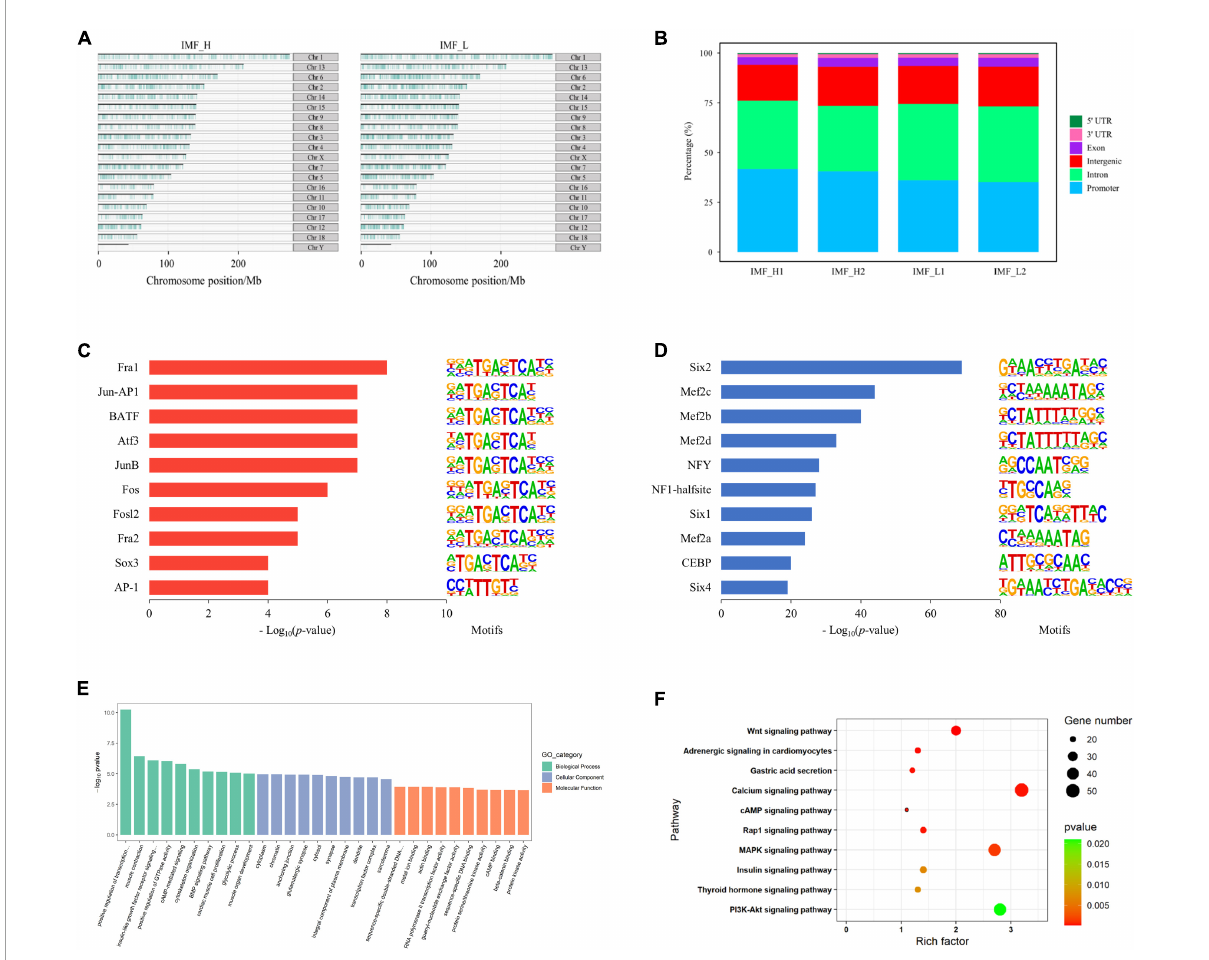
FIGURE2 Distribution of peaks and analysis of differential peaks. (A) The distribution of peaks on the chromosomes. (B) Genomic distribution of the peaks in each sample. Genomic functional regions include promoter, intergenic, exon, intron, 5’UTR and 3’UTR. (C) Enriched transcription factor binding motifs by increased peaks between the IMF_H and IMF_L by ATAC-seq. (D) Enriched transcription factor binding motifs by decreased peaks. (E) GO enrichment analysis of genes corresponding to differential peaks. (F) KEGG pathway enrichment analysis of genes corresponding to differential peaks.